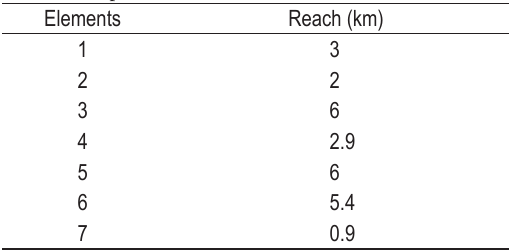
Table 2. Representation of simulated elements.